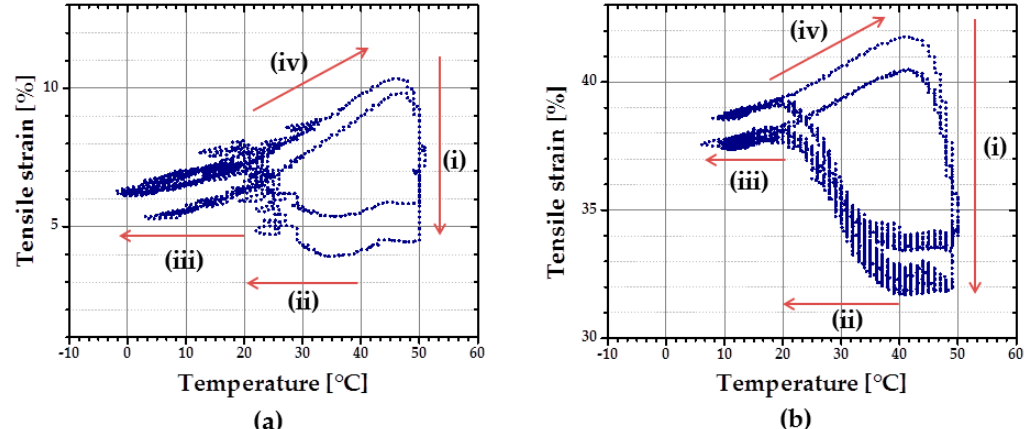
Figure 12 . Dependence of tensile strain from the temperature change during cyclic load free SME tests of cPCL-2/4/8k-180 programmed: ( a ) parallel to foam free rise; and ( b ) perpendicular to foam free rise. Heating and cooling rates were 3 K · min − 1 . The following four stages are marked: (i) shape recovery at T high ; (ii) length increase upon cooling; (iii) contraction upon cooling; and (iv) length increase upon heating.